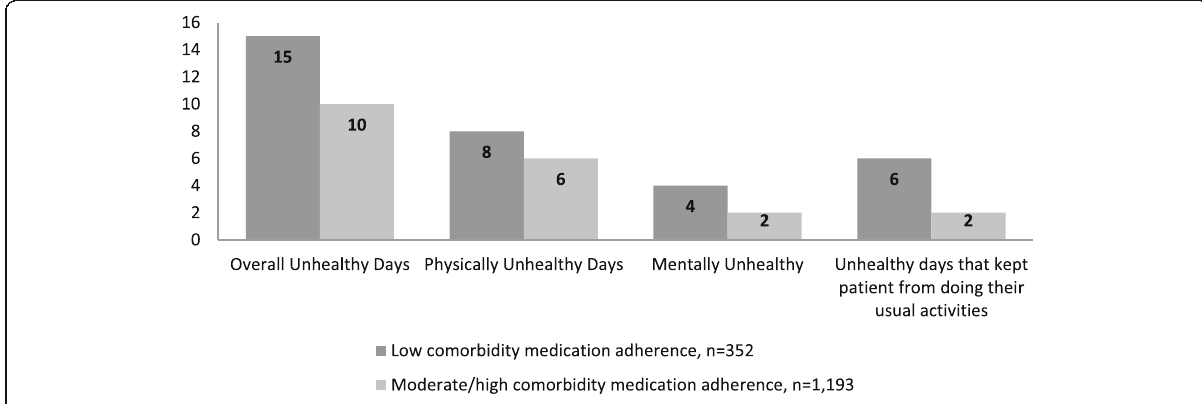
Fig. 1 Median number of unhealthy days overall and by comorbidity medication adherence a ( a All differences were statistically significant at the 0.05 level using the Wilcoxon rank sum